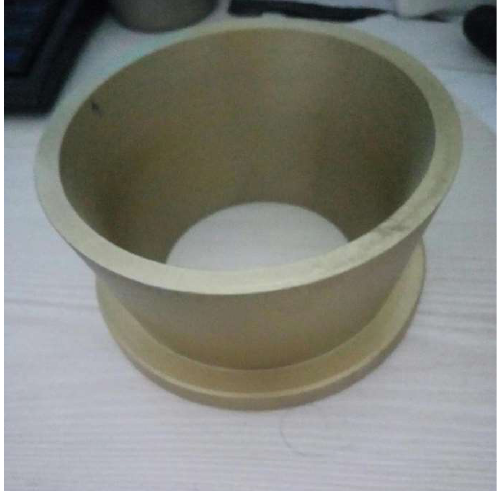
Figure 4. Truncated-cone round die. Table 4. Factors and levels in orthogonal test.